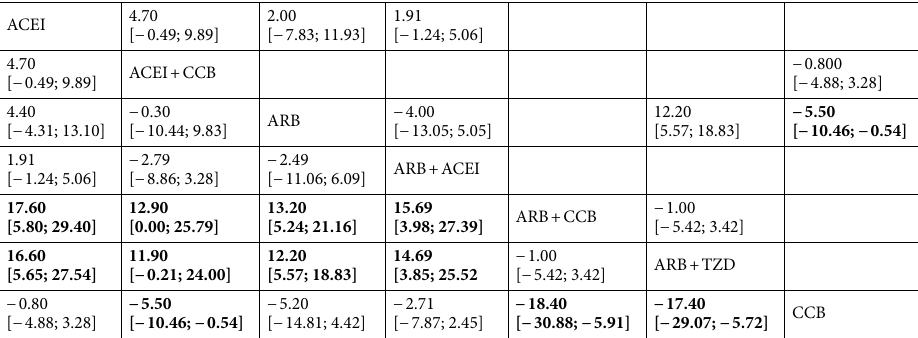
Table 3. Net league table of changes in SBP. ACEI, angiotensin converting enzyme inhibitors; ARB, angiotensin receptor blockers; CCB, calcium channel blockers; SBP, systolic blood pressure; SMD, standard mean difference; TZD, thiazide diuretics. Statistically significant values are expressed in bold.